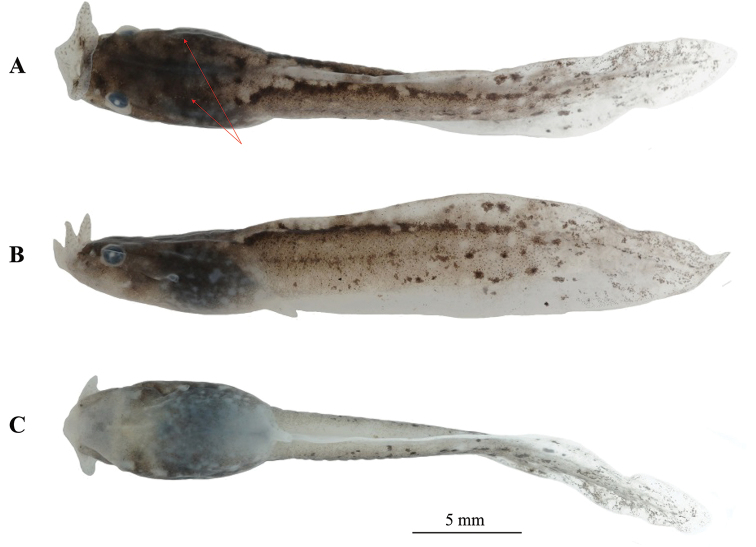
Tadpole specimen CIBXJT19050704 of Megophrys
xianjuensis sp. nov. A dorsal view B lateral view C ventral view. Arrows indicate two dotted lines on flank of dorsum from mouth to fin.